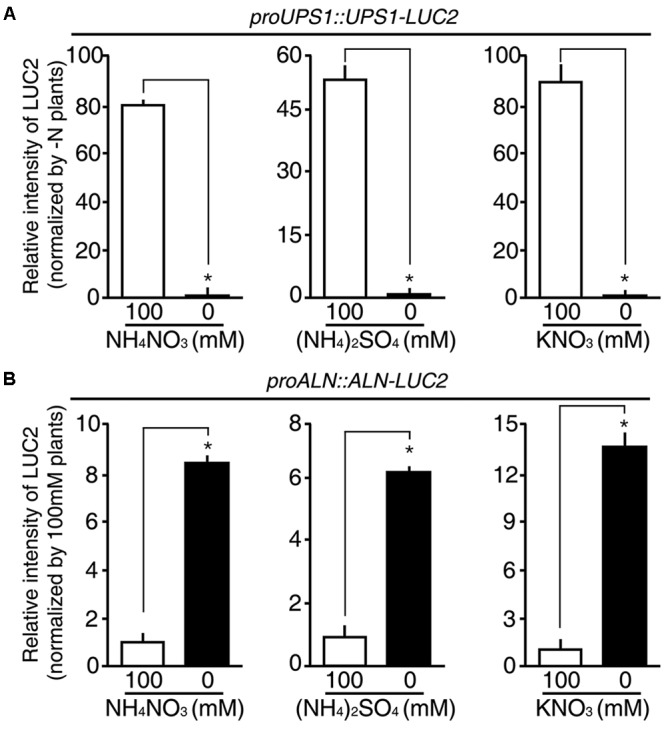
N substrate specificity of proUPS1::UPS1-LUC2 and proALN::ALN-LUC2 in rice. Relative intensity of the luminescence in T3 homozygous proUPS1::UPS1-LUC2
(A) and proALN::ALN-LUC2
(B) plants grown on GM–N (growth media –N) for 4 days, followed by addition of 100 mM ammonium nitrate, ammonium sulfate or potassium nitrate for 1 day. Data shown are the mean + SD of 5 T3 homozygous lines for each N sensor (n = 10 for each line).